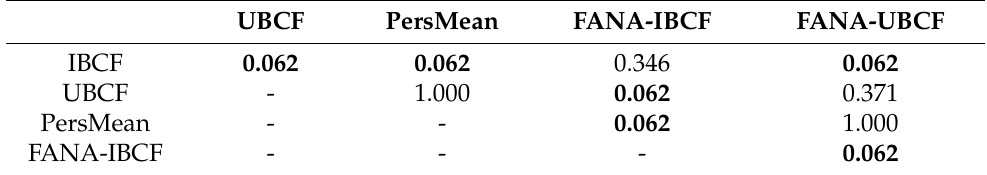
Table 8. Pairwise Wilcoxon signed-rank test of nDCG performance among IBCF, UBCF, PersMean, and our proposed approach, FANA-CF. The results in bold are statistically significant with a 90% confidence